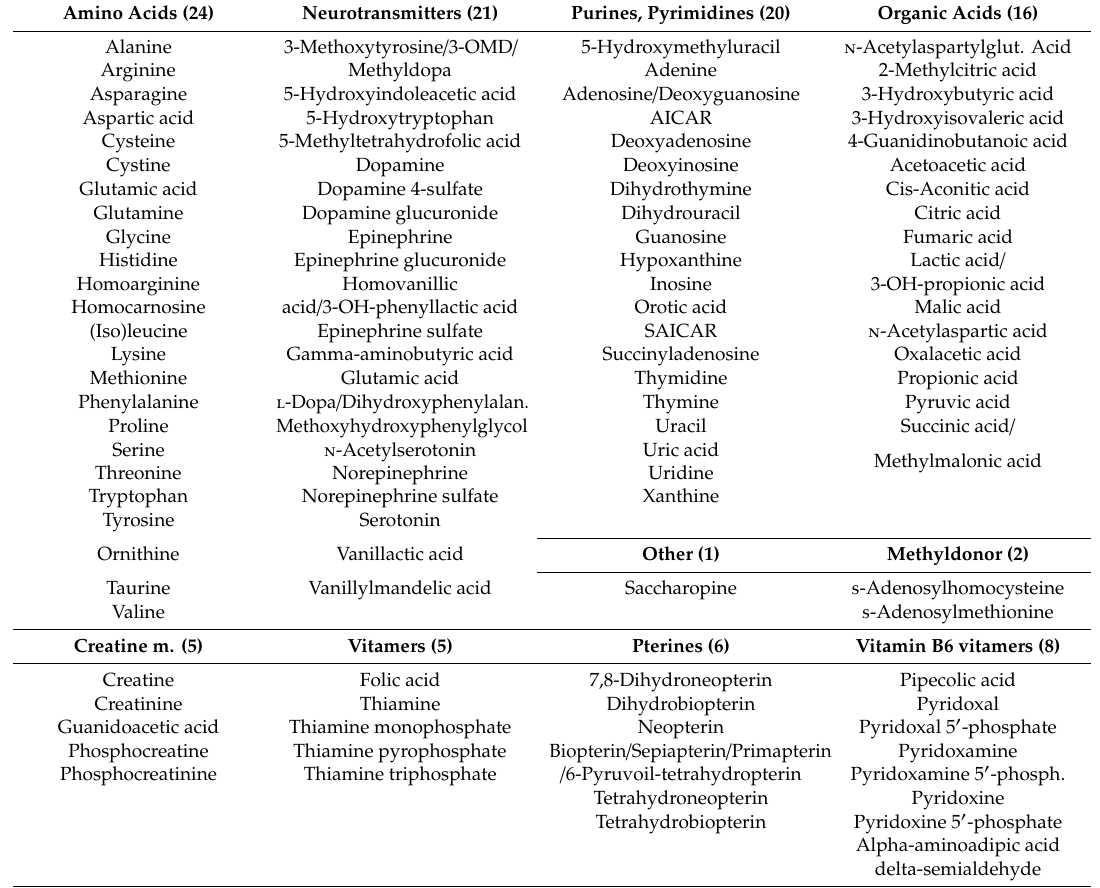
Table 2. 106 m / z peaks corresponding to metabolites important for neurometabolic diagnostics in the cerebrospinal